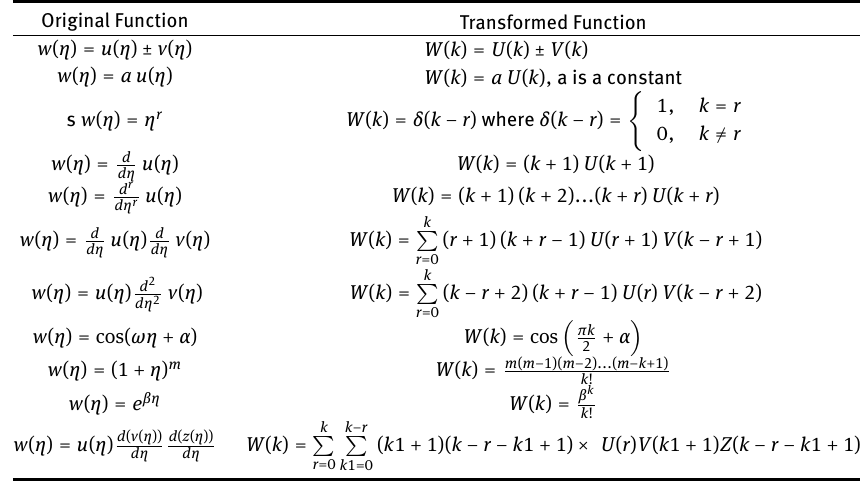
Table 1: The operators for the one dimensional differential transform method Original Function